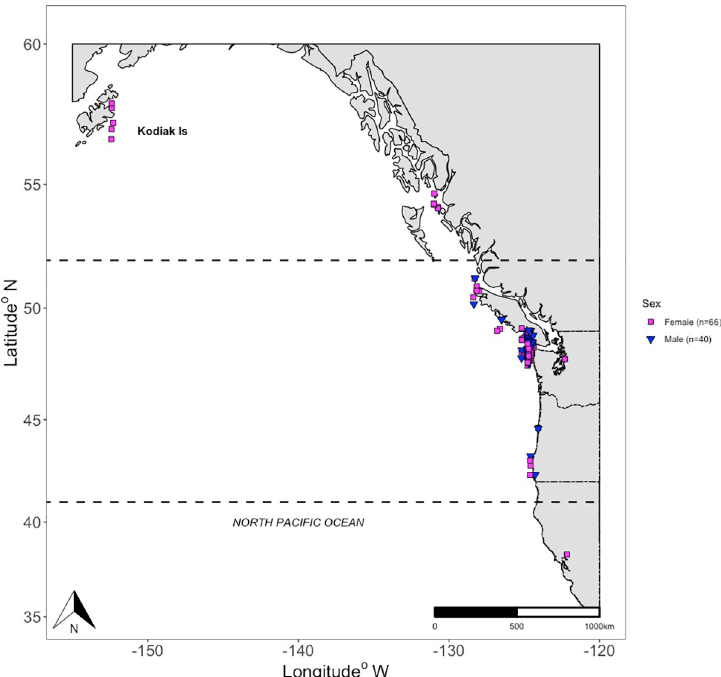
Fig 1. Map of the Pacific Ocean and west coast of North America with gray whales sampling locations color-coded by sex. Blubber biopsy samples were collected off the United States coasts of California (CA, n = 2), Oregon (OR, n = 6), Washington (WA, n = 71) and Alaska (AK, n = 5), and in Canadian waters of British Columbia (BC, n = 22). Dashed lines mark distribution boundaries of